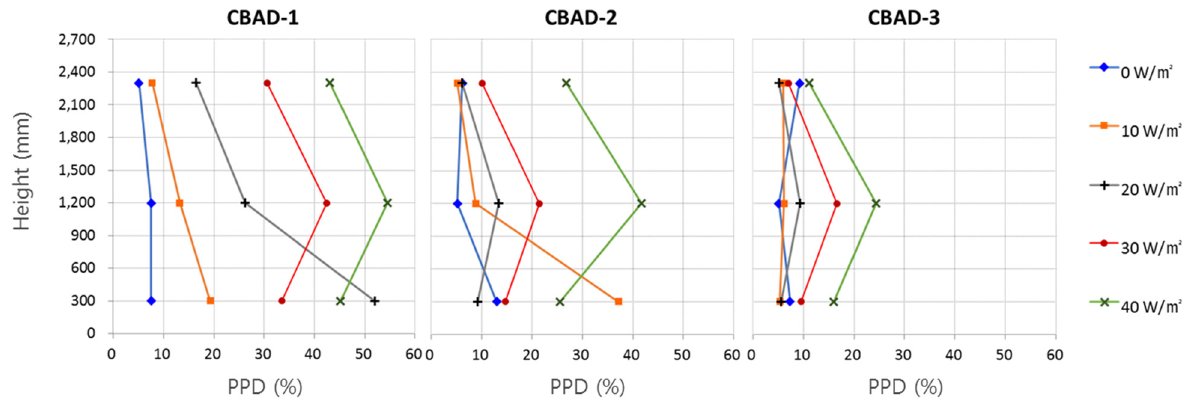
Figure 24. Vertical distribution of PPD at (X1, Y2), CBAD.